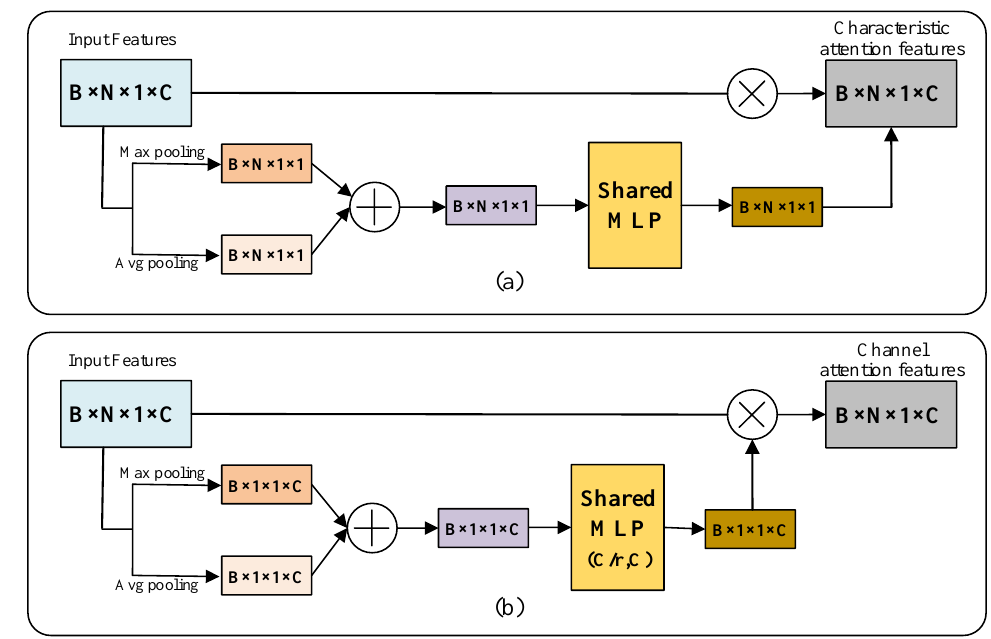
Figure 14. Point cloud attention mechanisms. ( a ) Point cloud feature attention mechanism A c ∗ for fusion first and training later; ( b ) Point cloud channel attention mechanism A n ∗ for fusion first and training later.